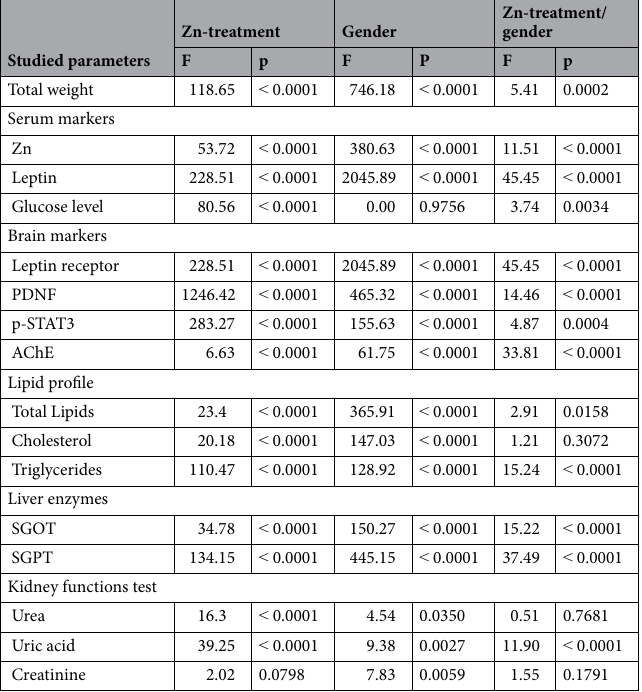
Table 2. Two way ANOVA analyses of all studied parameters in all groups regarding gender, Zn treatment, and gender versus ZnSO 4